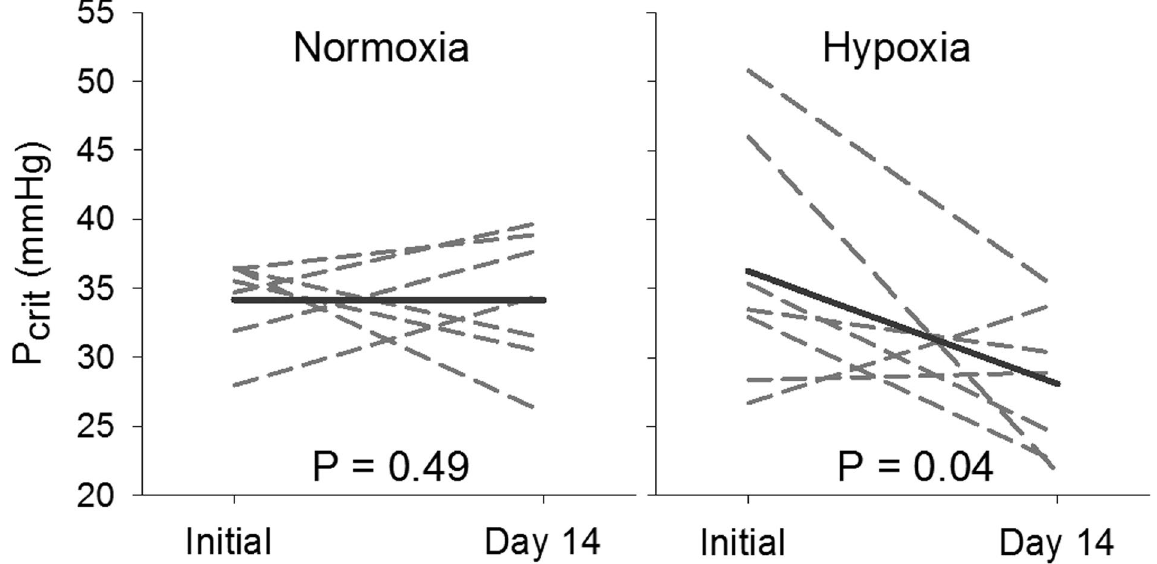
Figure 5. Critical oxygen threshold (P crit ) of fish before and after a 14 day acclimation to normoxia ( A ) and hypoxia ( B ). Dashed lines represent individual fish and solid lines represent the mean of fish within the respective treatments.